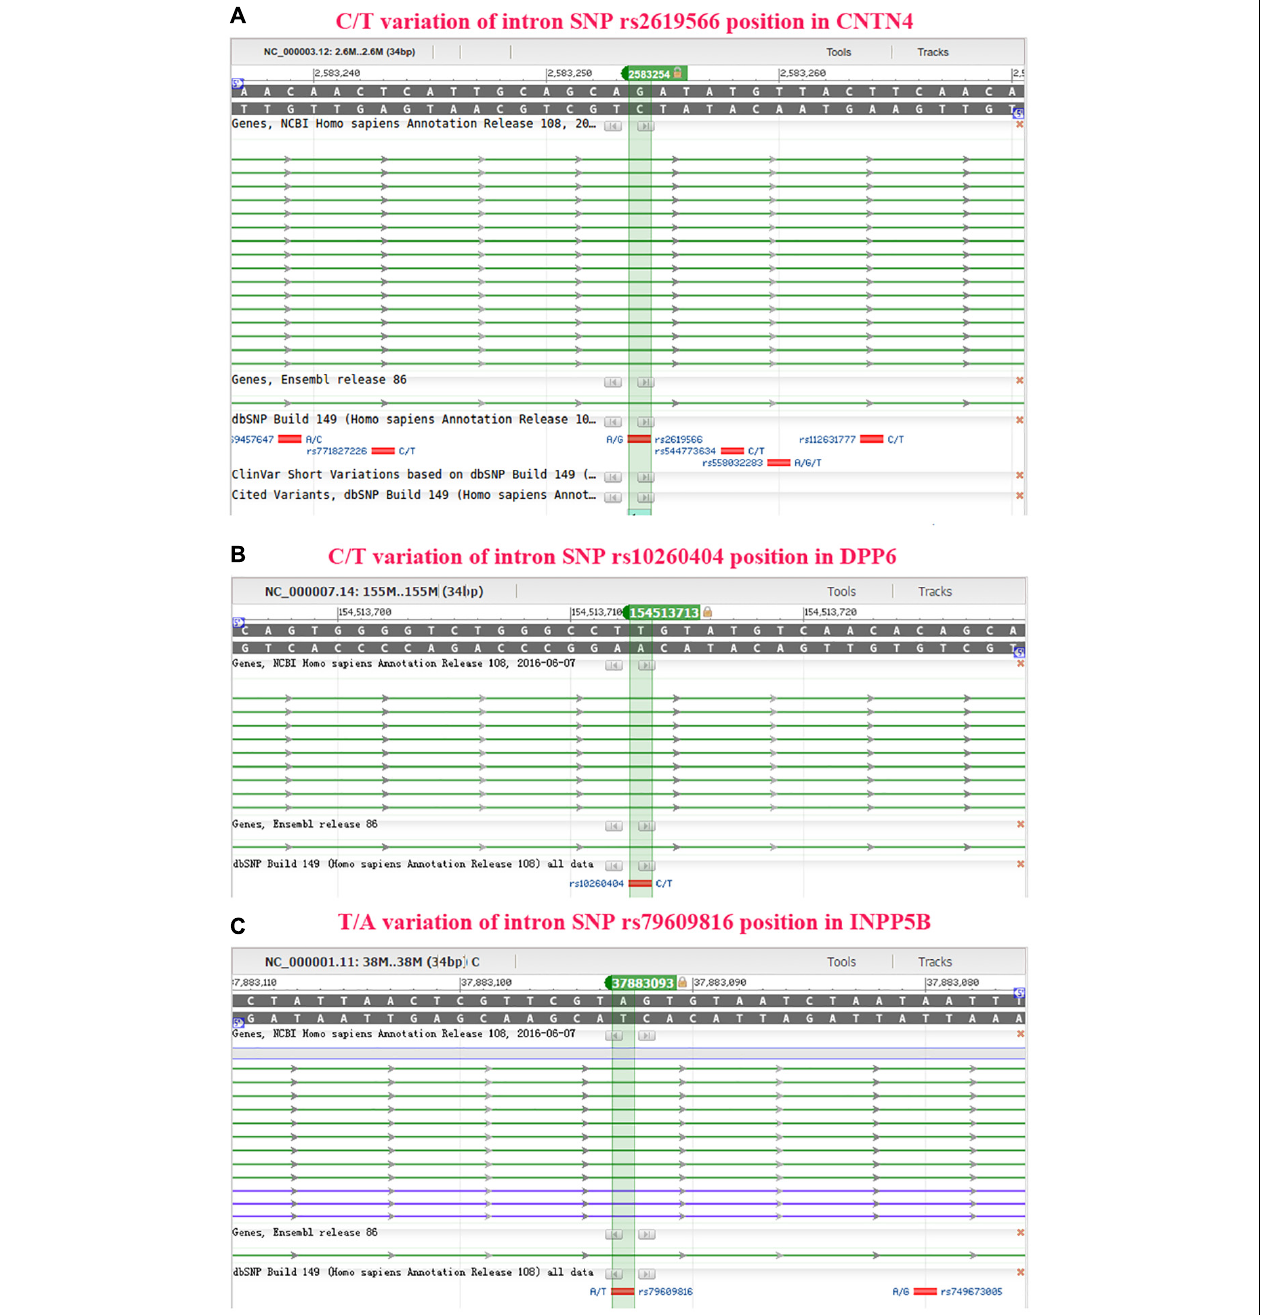
FIGURE 3 | The rs2619566 variants in the CNTN4 gene, rs10260404 variants in the DPP6 gene, and rs79609816 variants in the INPP5B gene. (A) The rs2619566 T > C SNP site is shown in the CNTN4 gene. (B) The rs10260404 T > C SNP site is shown in the DPP6 gene. (C) The rs79609816 A > T SNP site is shown in the INPP5B gene. The variant loci are marked by using a green